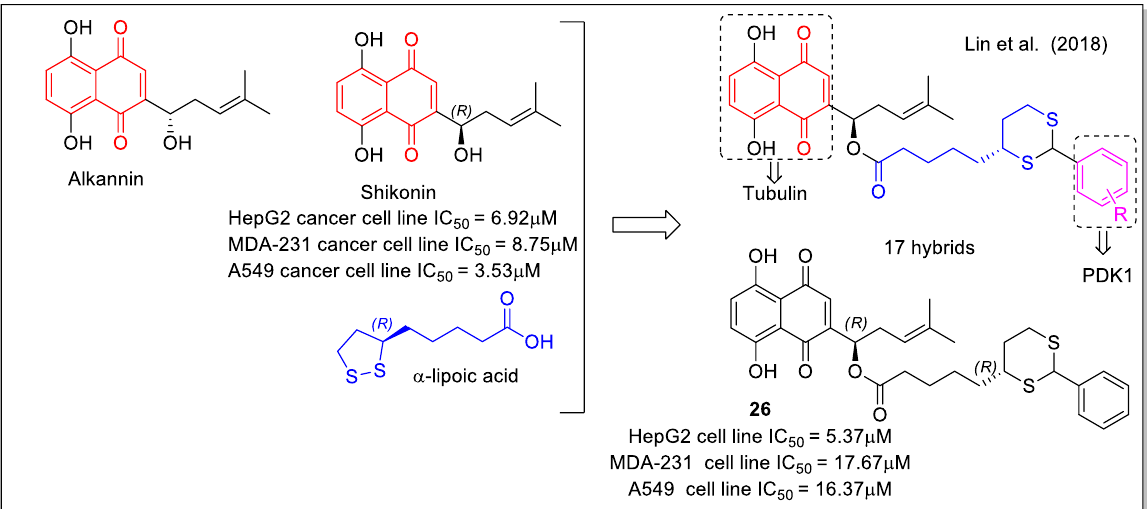
Figure 10. Shikonin-lipoic acid hybrid as reported by Lin et al. [41].